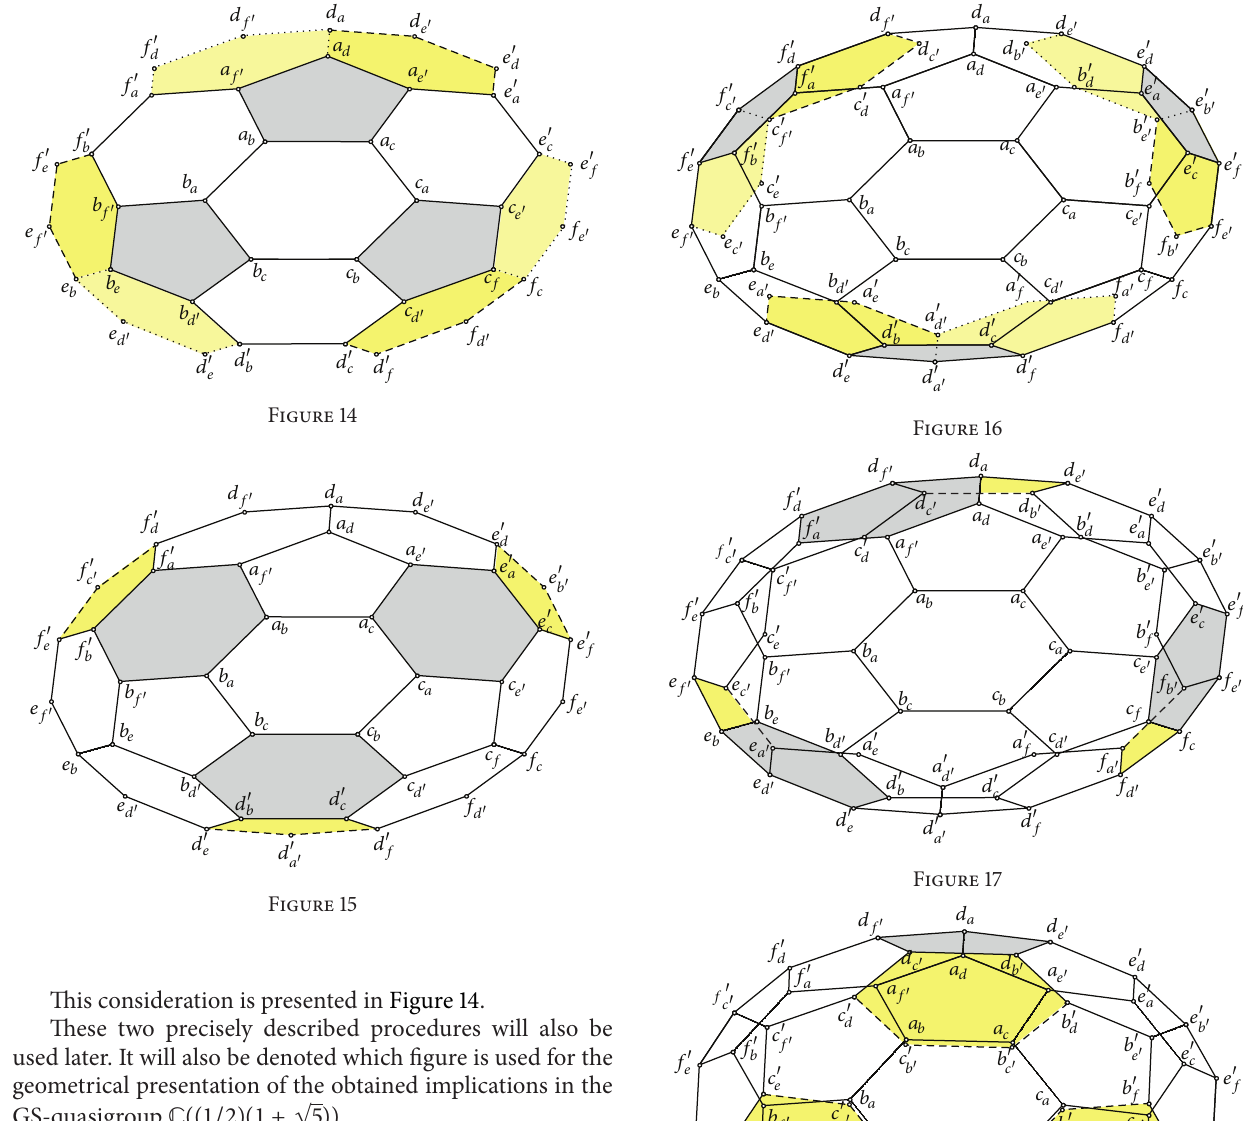
, 𝑓 , 𝑓 , 𝑓 , 𝑓 ) 𝑒 󸀠 𝑏 󸀠 𝑎 󸀠 𝑑 󸀠 𝑐